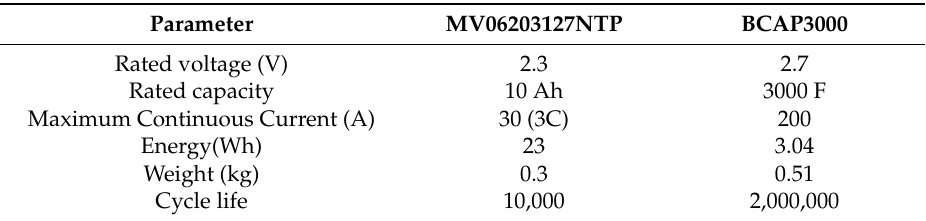
Table 3. Parameters of battery and